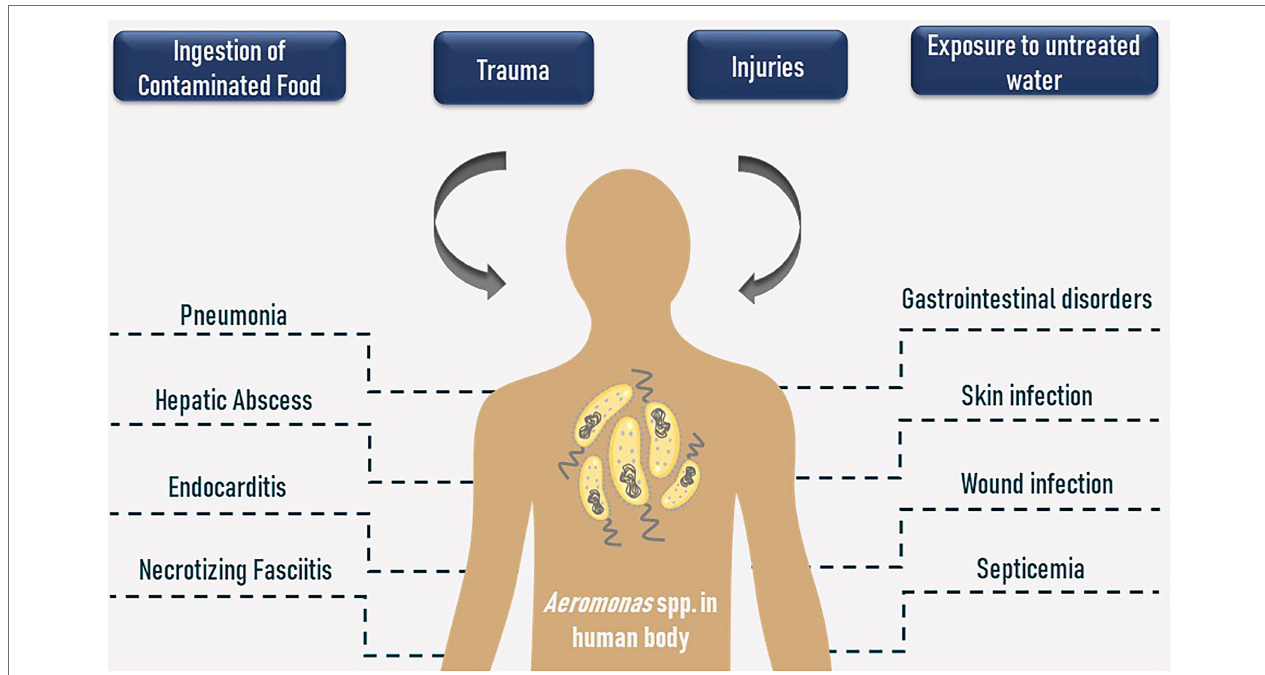
FIGURE 1 | Contamination routes and human health disorders caused by Aeromonas